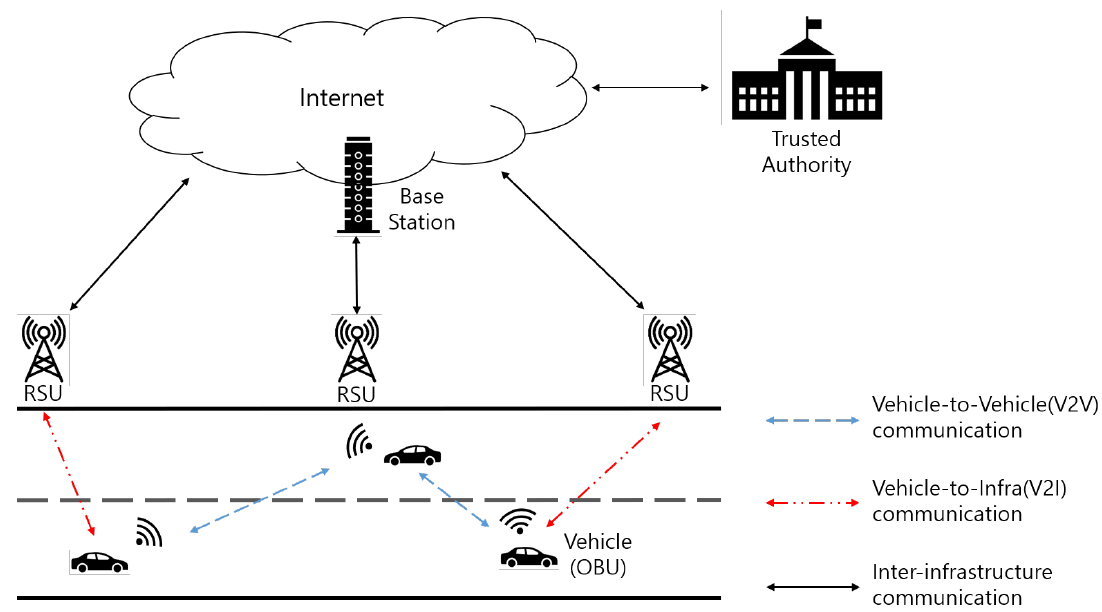
Figure 1. Vehicle ad hoc network